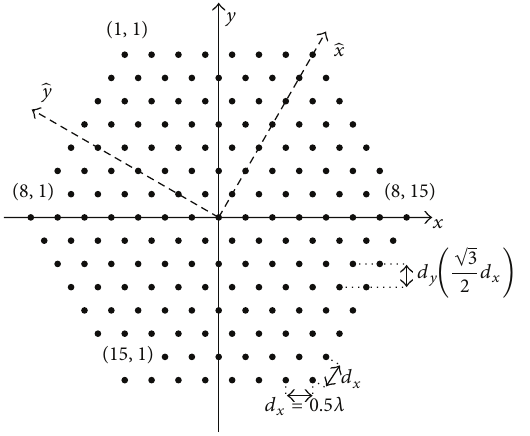
Figure 6: The Standard Hexagonal Array features equally spaced antenna elements and multiple pseudo-principal axes.